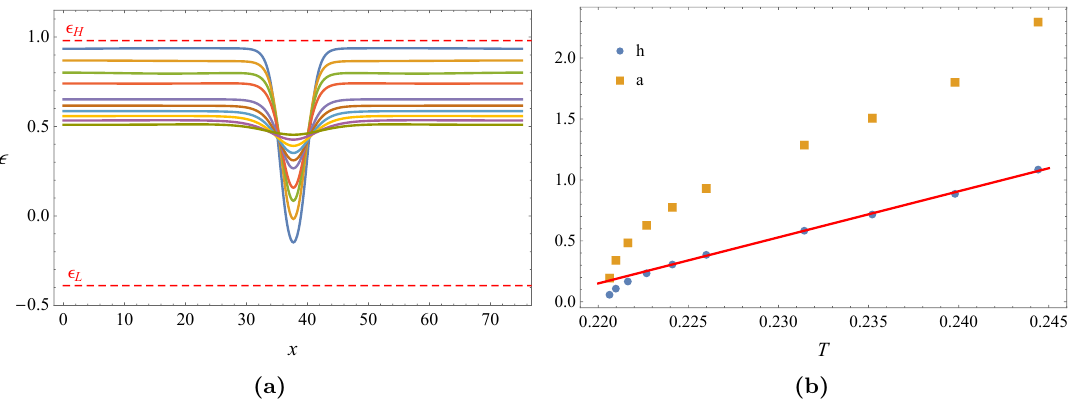
Figure 10. (a): the energy densities of the critical nucleus at different temperatures. The hori- zontal red dashed lines represent the energy densities at the phase transition temperature in homo- geneous solutions. (b): the depth of critical nuclei (blue dots) and the amplitude of Gaussian-like seeds (orange squares) with respect to